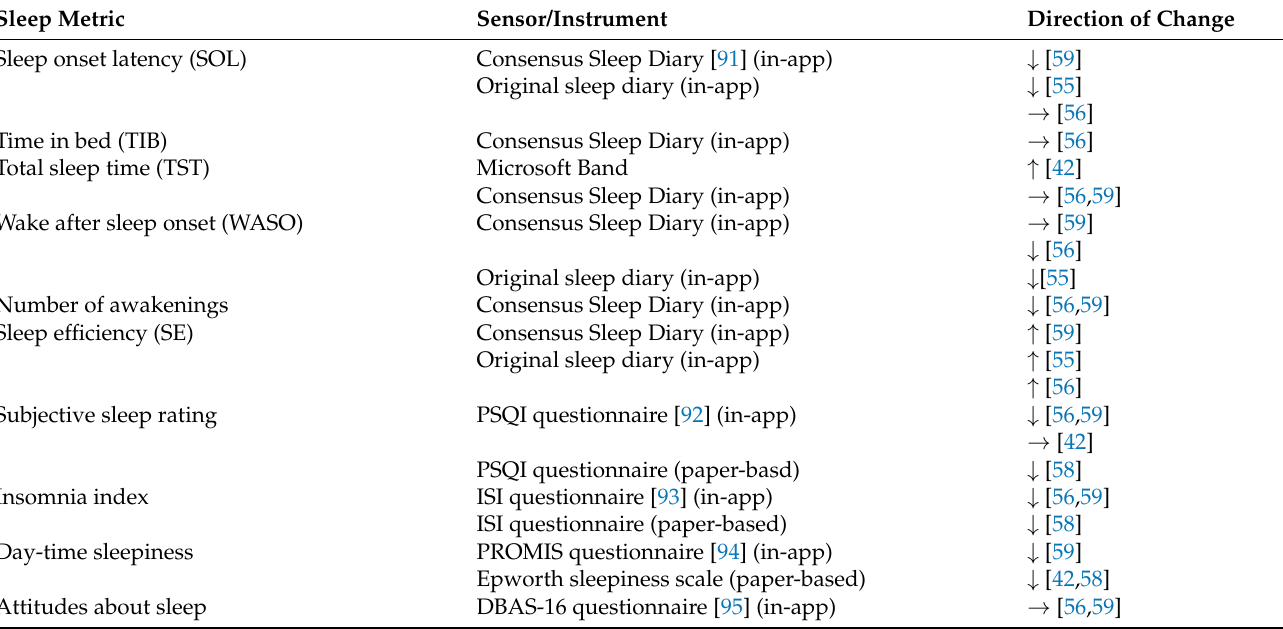
Table 9. CASHRS evaluation centered on